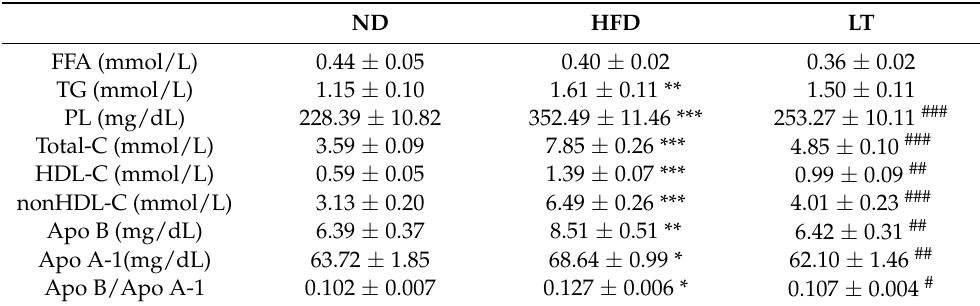
Table 2. Effect of Lycopus lucidus Turcz water extract supplement for 13 weeks on plasma lipid profiles in C57BL/6J mice fed a